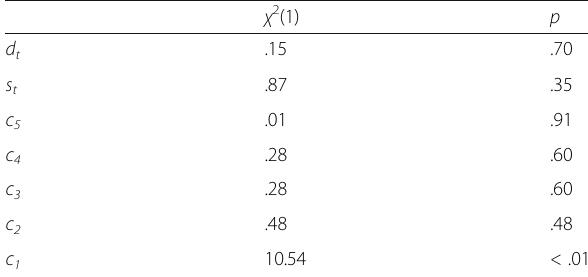
Table 6 Likelihood ratio tests comparing fits of unconstrained models to a series of constrained models where equality for each parameter is imposed across the simultaneous and sequential conditions